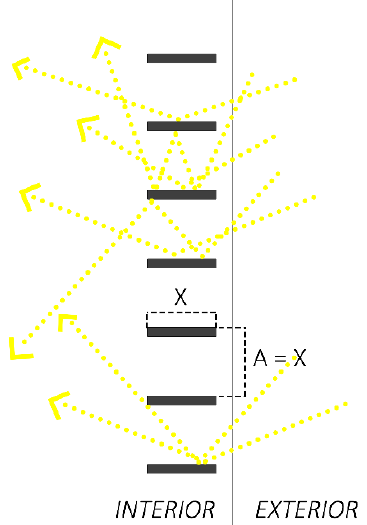
Figure 5. Illustration of modelled fixed horizontal shading device.